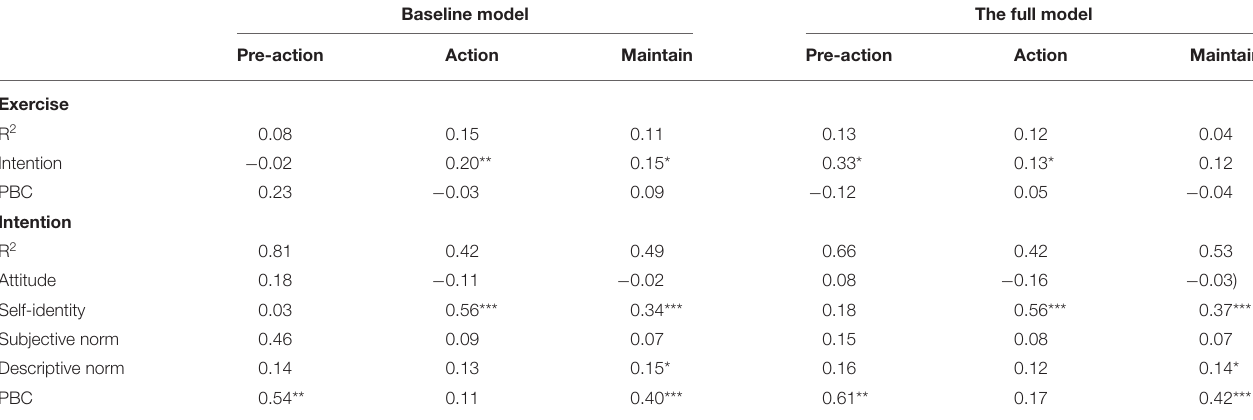
TABLE 3 | Multiple regression analysis predicting behavioral intention and behavior across the